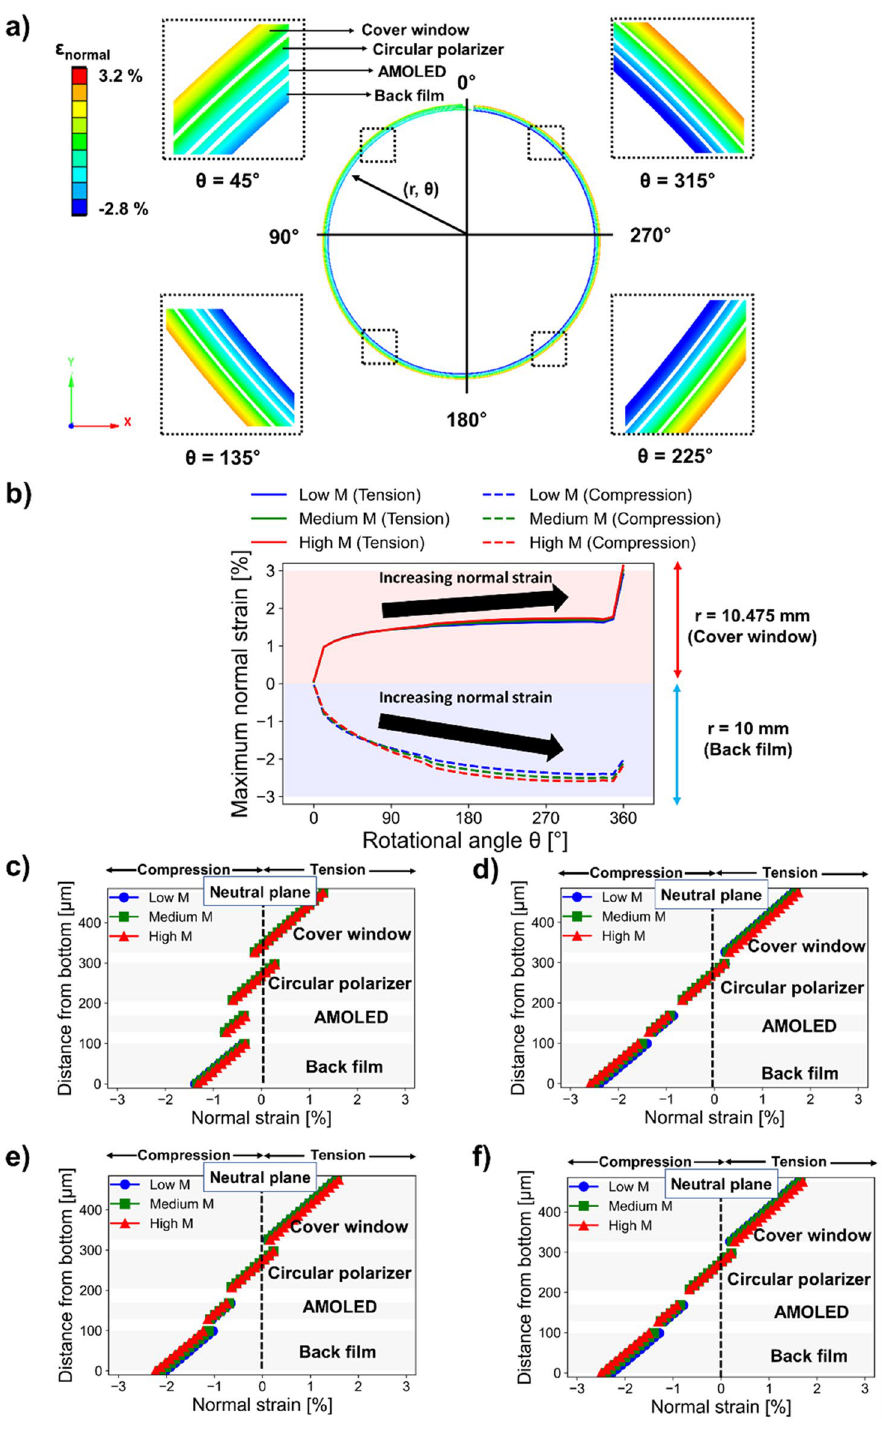
Figure 4. Conventional analysis of multi-layers rollable display using simple linear elastic OCA model. ( a ) FEM images showing the normal strain distributions with a mid-modulus OCA value. ( b ) Measurements of maximum tensile and compressive strains depending on the rotational angle. ( c – f ) Normal strain distributions at the cross-section of rigid functional layers at θ = 45°, 315°, 135°, and